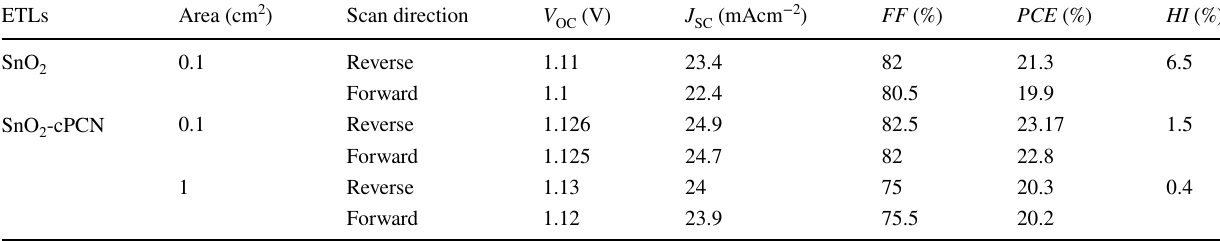
Table 1 Device performance of champion PSCs based on SnO 2 and SnO 2 -cPCN ETLs ETLs Area (cm 2 ) Scan